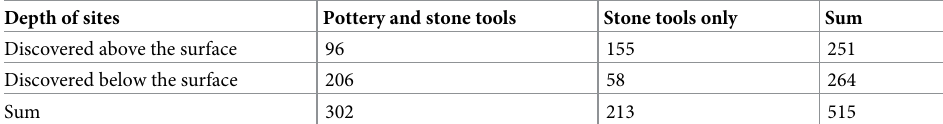
Table 1. Dataset used in random forests